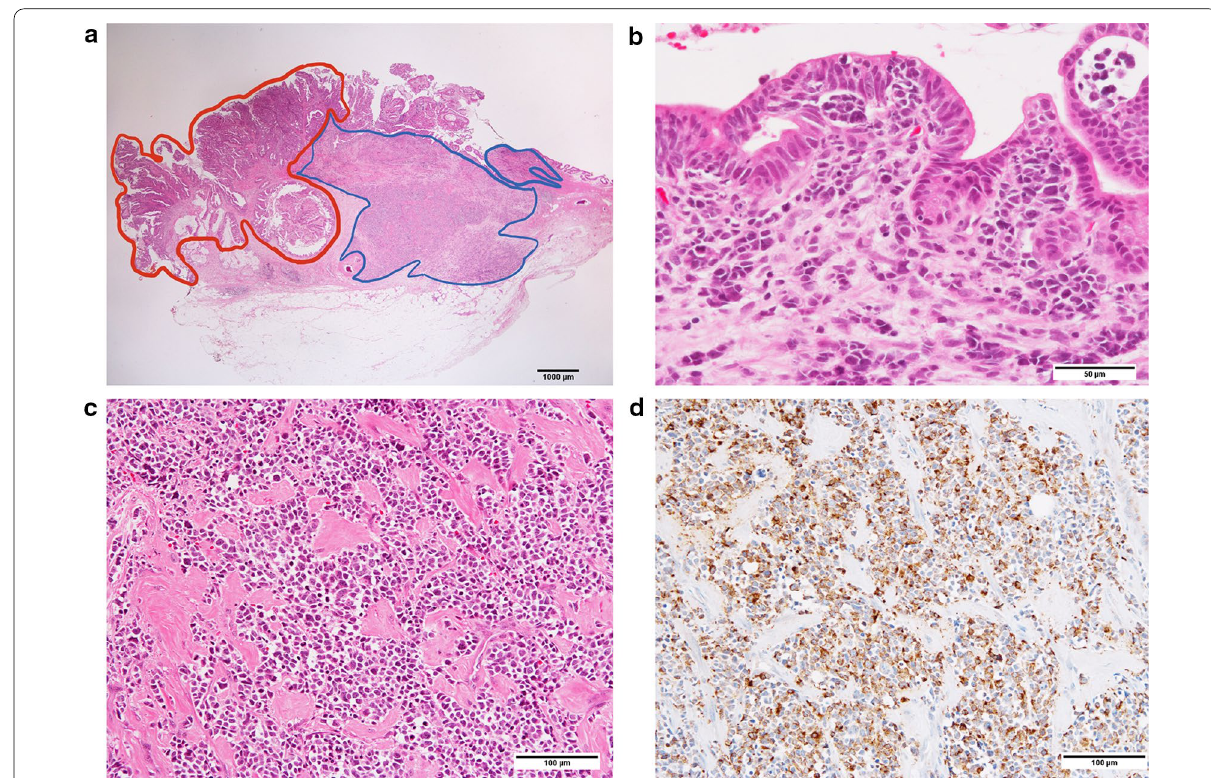
Fig.3 Histological findings of gallbladder tumor. a Hematoxylin–eosin staining ( tumor (red area), whereas neuroendocrine component in the deeper subserosal layer (blue area). b Hematoxylin–eosin staining ( tubular adenocarcinoma. c Hematoxylin–eosin staining (